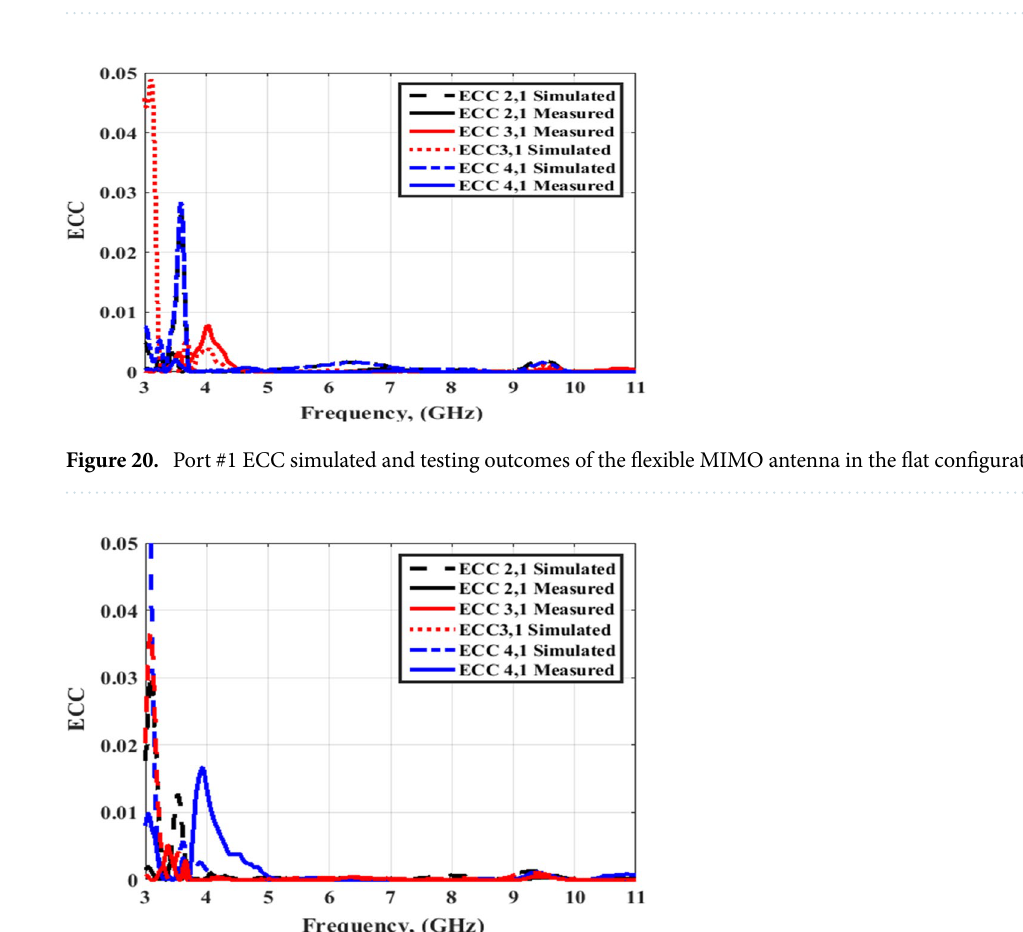
Figure 19. Port #1 peak gain simulated and testing outcomes of the flexible MIMO antenna in bending configuration with R = 45 mm.